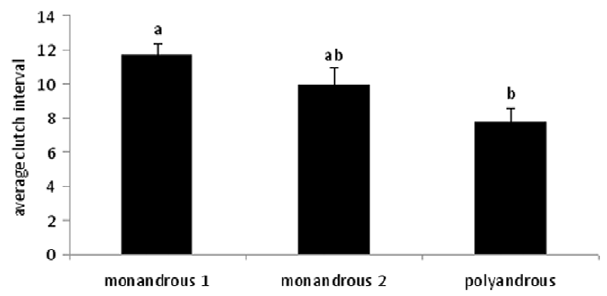
Figure 2. The average clutch interval (days) between monan- drous 1, monandrous 2 and polyandrous females. Different